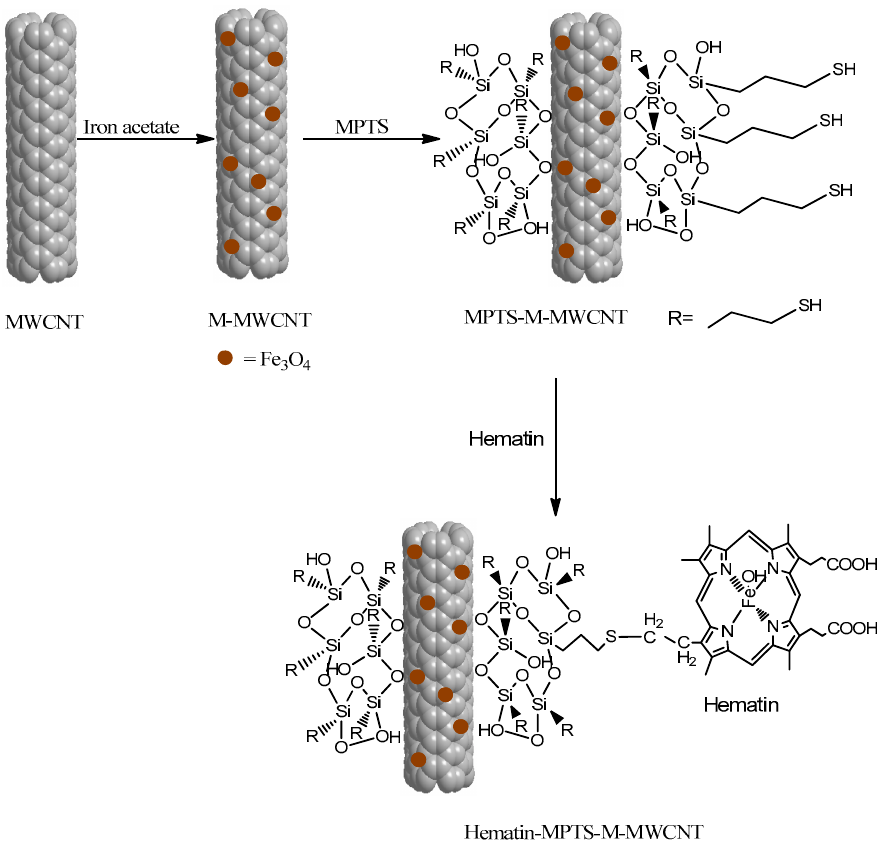
Scheme 1. Schematic presentation of the procedures for grafting hematin. MWCNT: multiwalled carbon nanotube; M ‐ MWCNT: magnetic MWCNT; MPTS ‐ M ‐ MWCNT: MPTS ‐ coated M ‐ MWCNT. Hematin was grafted on MPTS ‐ M ‐ MWCNT through the reaction between the ‐ SH and alkene groups.